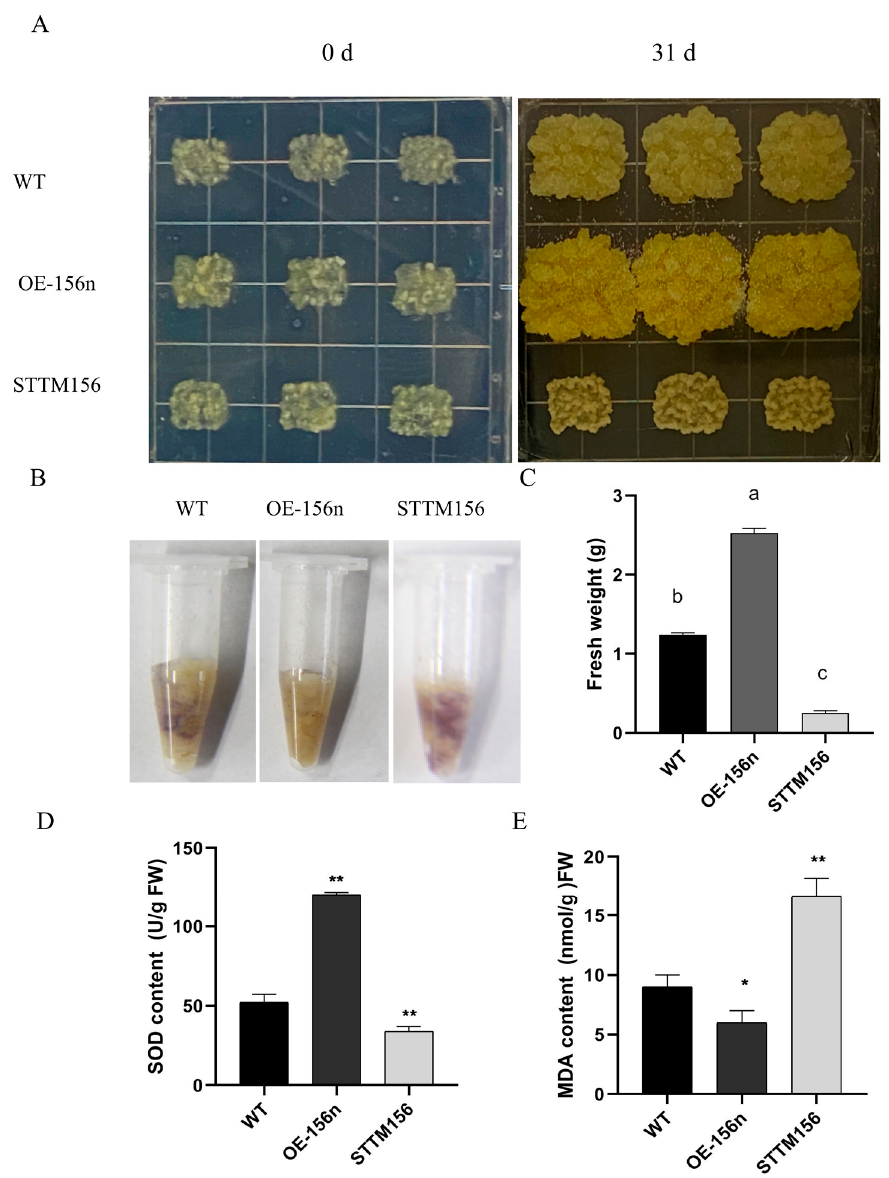
Figure 1. Mdmir156n is involved in drought stress in apple calli: ( A ) WT, OE-156n, and STTM156 apple calli cultured in medium with 6% PEG. ( B ) Histochemical staining of NBT for O 2 − accumulation in apple calli after PEG treatment for 0.5 h. ( C ) The weights of WT, OE-156n, and STTM156 apple calli lines after 6% PEG treatment for 31 d. Different letters indicate statistical differences ( p < 0.05). ( D ) Measurement of SOD activities. ( E ) Measurement of MDA content. Asterisks indicate statistically significant differences (* p < 0.05, ** p < 0.01, one-way ANOVA). Values are means SD of three independent biological